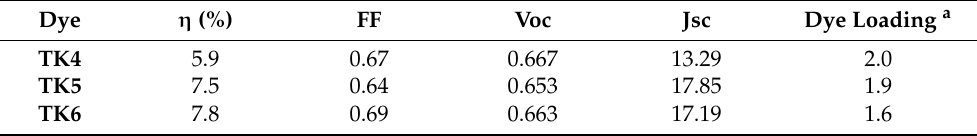
Table 8. Photovoltaic performance of TK4 , TK5 and TK6 .